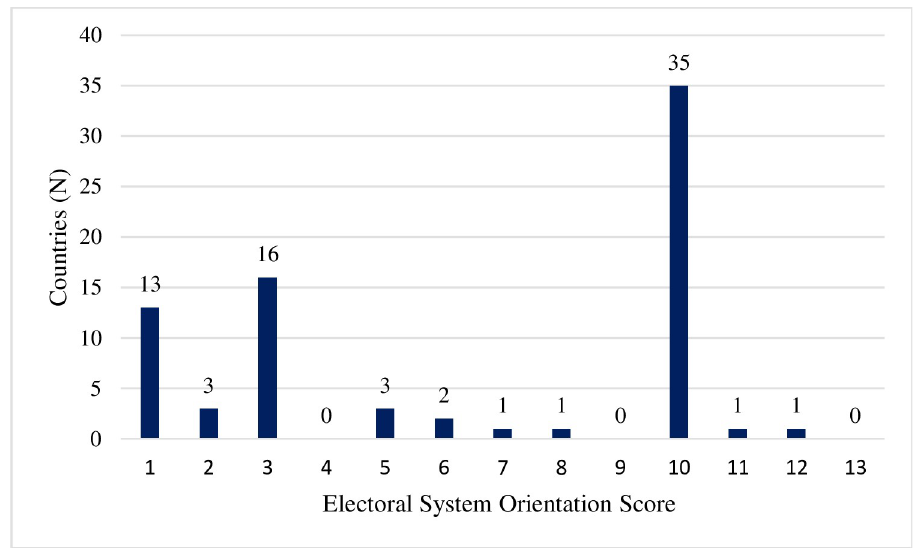
Fig 2. Electoral system orientation